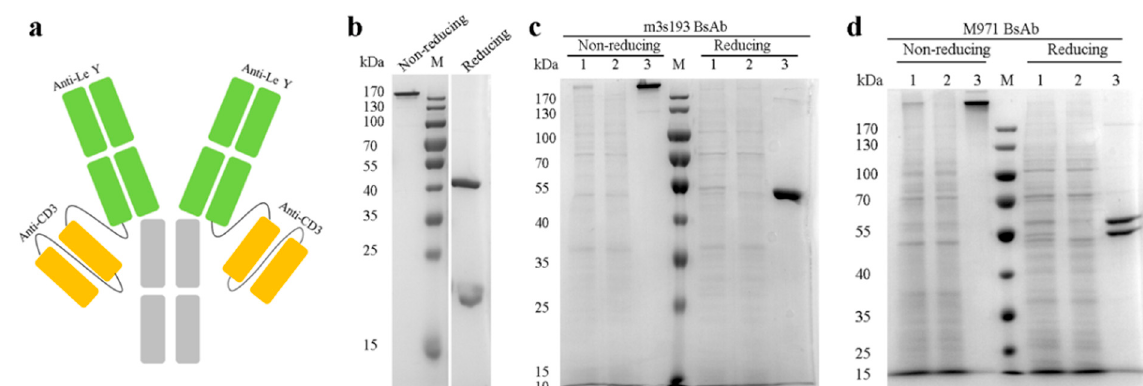
Figure 1. Structure schematic of m3s193 BsAb and purification of the proteins. ( a ) Molecular design of m3s193 BsAb with IgG-[L]-scfv structure. ( b ) SDS-PAGE analysis of purified m3s193 mAb. ( c ) SDS-PAGE analysis of purified m3s193 BsAb. ( d ) SDS-PAGE analysis of purified M971 BsAb. Lane 1, the supernatant before purification; lane 2, the flow through after purification; and lane 3, the elution of proteins.